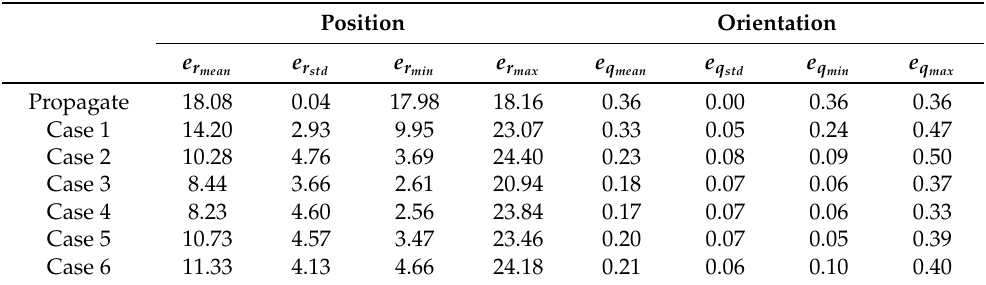
Table 7. Position (m) and quaternion error statistics across 100 simulations of all vehicles for Scenario 2.